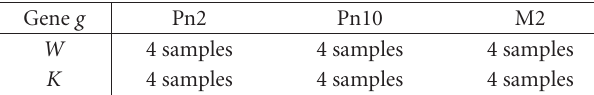
Table 1: The knockout versus wild-type experiment is equiva- lent to a two-way layout of treatment ( W or K ) and time ( t = Pn2, Pn10,